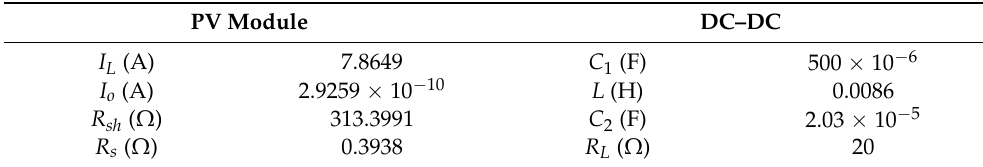
Table 1. Parameters of mathematical model of photovoltaic and DC – DC circuit.